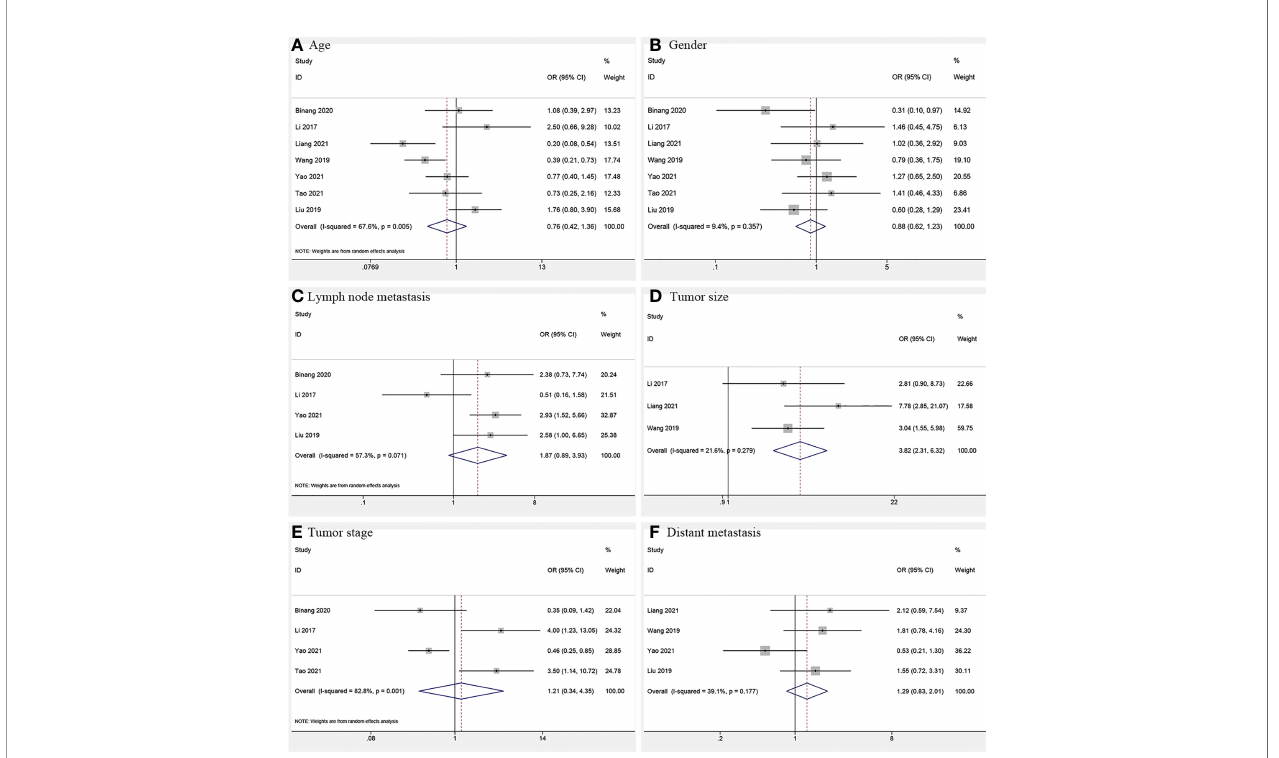
FIGURE 6 | Forest plots for association of FOXP4-AS1 expression with clinicopathological features: (A) Age. (B) Gender. (C) Lymph node metastasis. (D) Tumor size. (E) Tumor stage. (F) Distant metastasis.